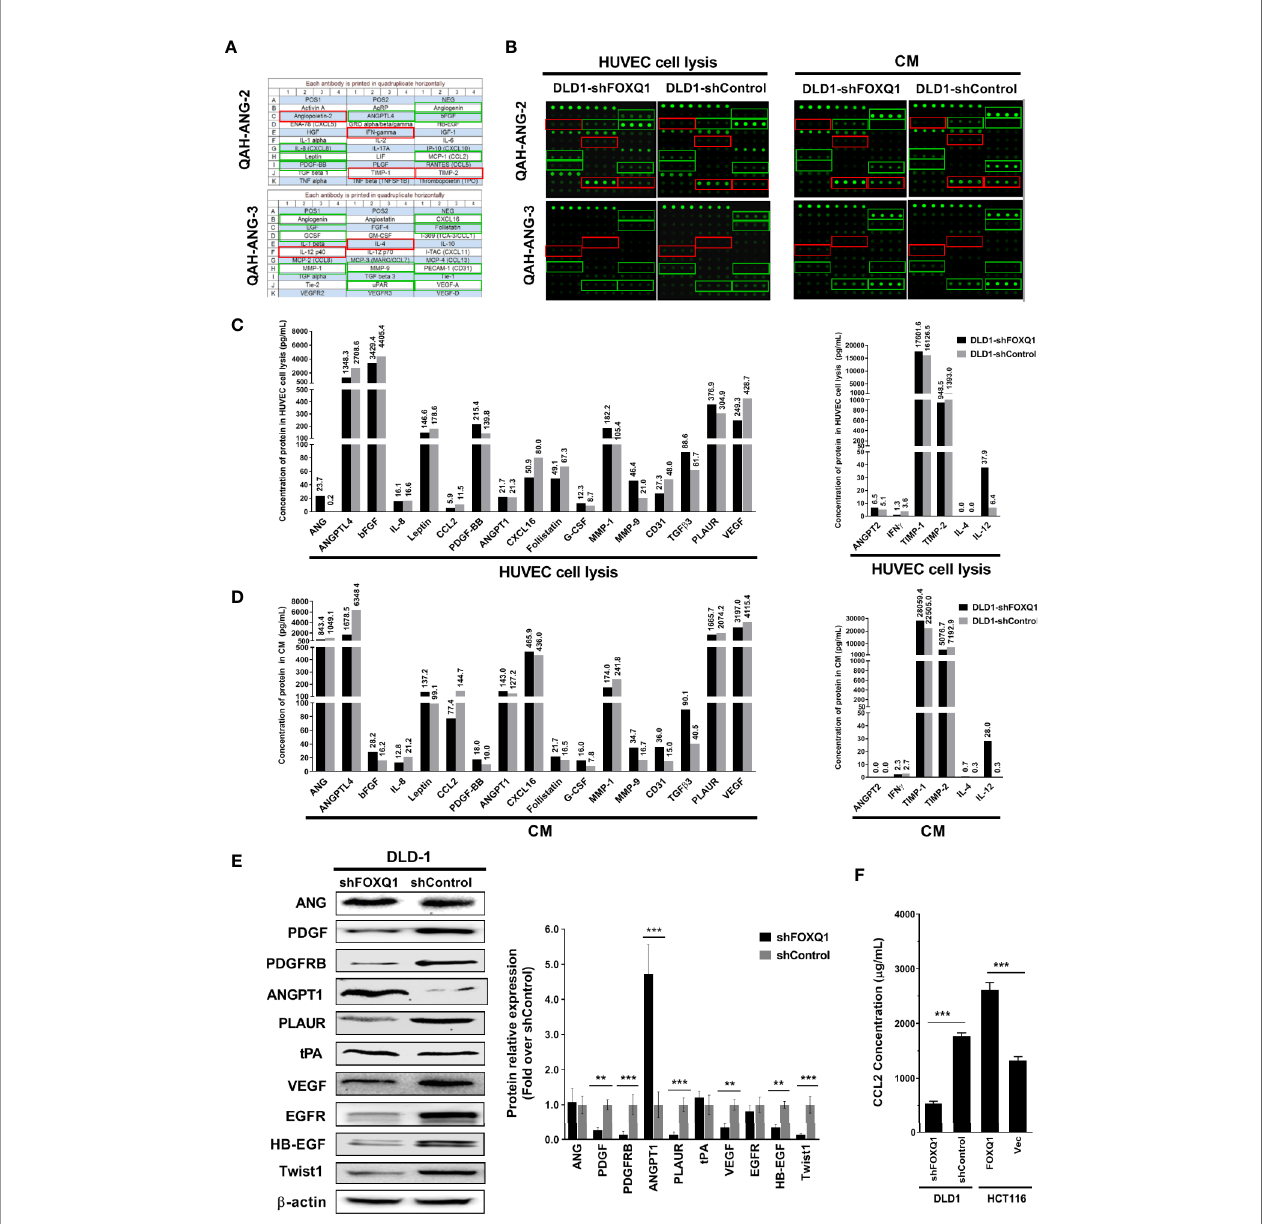
FIGURE 5 | Inhibition of FOXQ1 induces downregulation of angiogenic factors and upregulation of angiogenic inhibitors. (A) Matrix distribution of 60 well-established angiogenic proteins on a Quantibody Human Angiogenesis Array (QAH-ANG-2 and QAH-ANG-3); each protein is distributed in quadruplicate horizontally. (B) Fluorescence detection of protein arrays for either cell lysate of HUVECs or conditioned medium (CM) of colorectal cancer (CRC) cells. CM was collected from either DLD1-shFOXQ1 or DLD1-shControl and added to HUVECs. After 48 h, HUVECs were harvested and lysed. Both the cell lysates and CM were collected, and the secretion of 60 angiogenic proteins were measured by hybridization with QAH-ANG-2 and QAH-ANG-3. The 17 green and 6 red rectangles on (A, B) show 17 angiogenesis factors and 6 angiogenic inhibitors within the detection range of the protein array. (C) Quantitative concentration of the 17 angiogenic factors and 6 angiogenic factors in cell lysates of HUVECs (pg/ml). (D) Quantitative concentration of the 17 angiogenic factors and 6 angiogenic factors in CM collected from either DLD1-shFOXQ1 or DLD1-shControl (pg/ml). The values above each bar on (C, D) represent quantitative concentration of corresponding protein, is the average of quadruplicates (n = 1 per group). (E) Western blot analyses for ANG, PDGF, PDGFRB, ANGPT1, PLAUR, tPA, VEGF, EGFR, HB-EGF, and Twist1 were performed with DLD1-shFOXQ1 and DLD1-shControl cell lysates. b -actin was used as the loading control. (F) Inhibition of FOXQ1 prevented the autocrine secretion of CCL2, whereas overexpression of FOXQ1 enhanced the secretion of CCL2, as determined by ELISA analysis. ** P <0.01, *** P <0.001 signi fi es a signi fi cant difference between the indicated groups (two-tailed, unpaired Student ’ s t -test). Bars represent mean ± S.E. of three independent experiments. HUVEC, human umbilical vein endothelial cell; CM, conditioned